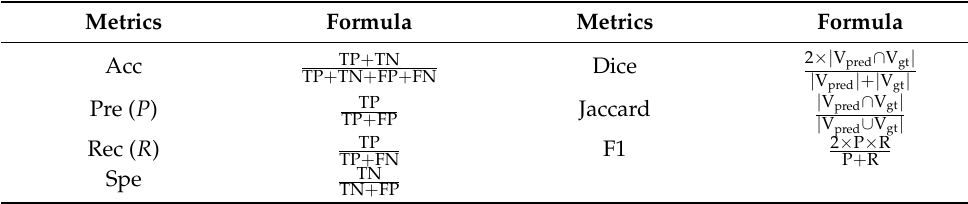
Table 3. Evaluation